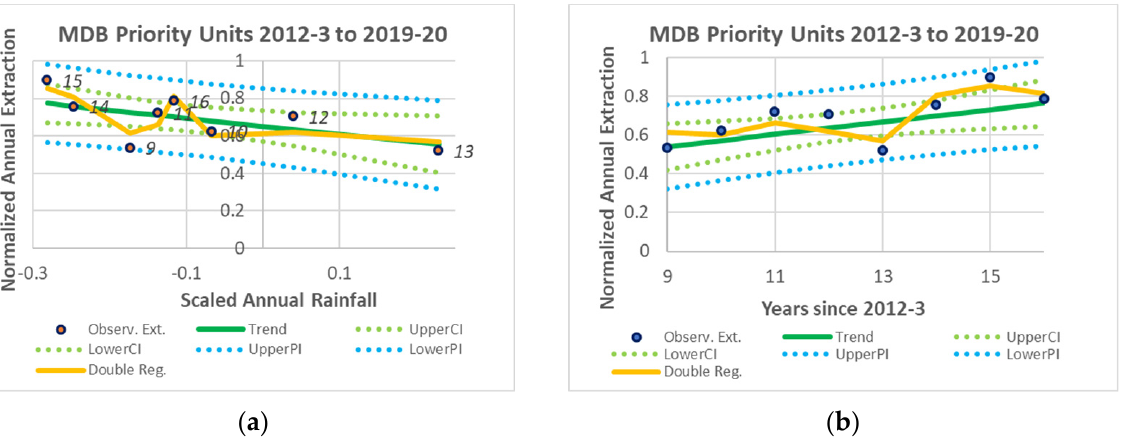
Figure 5. Plots of normalized annual extraction for the whole of the MDB for the period of 2012–2013 to 2019–2020 ( a ) with respect to scaled annual rainfall and ( b ) with time (years since 2003–2004 year. For ( a ), trend line for double regression at year 2015 is also shown with confidence interval and prediction interval as well as the full double regression results. Data labels represent years since 2003–2004. For ( b ), the multilinear regression trend and full and linear regression for the 2012–2013 to 2018–19 period as well as the confidence and prediction intervals are shown.